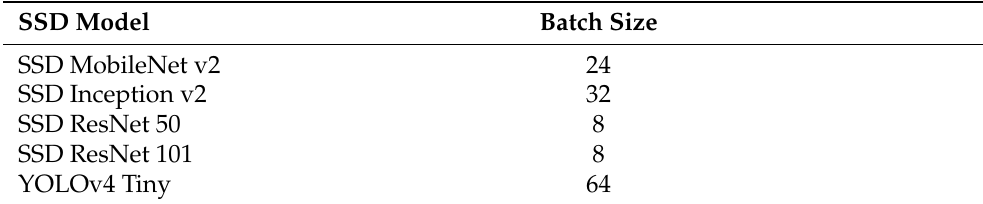
Table 3. Training batch size for each